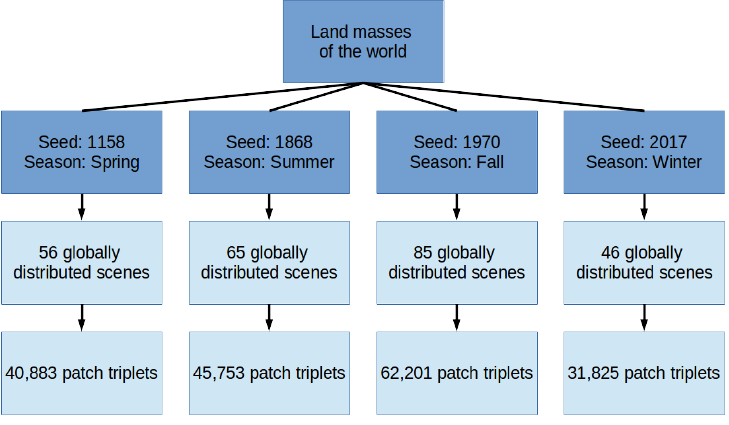
Figure 5. Tree structure of the final dataset.